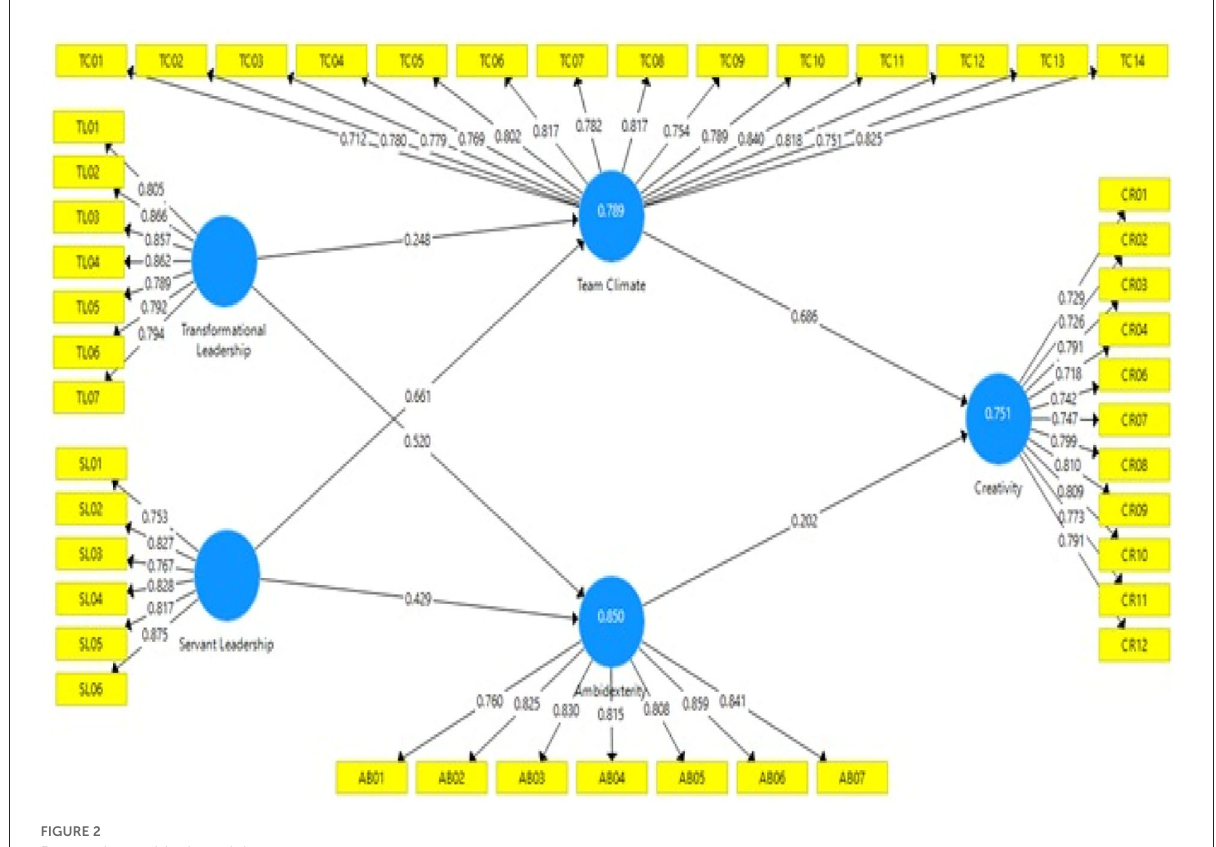
FIGURE2 Research empirical